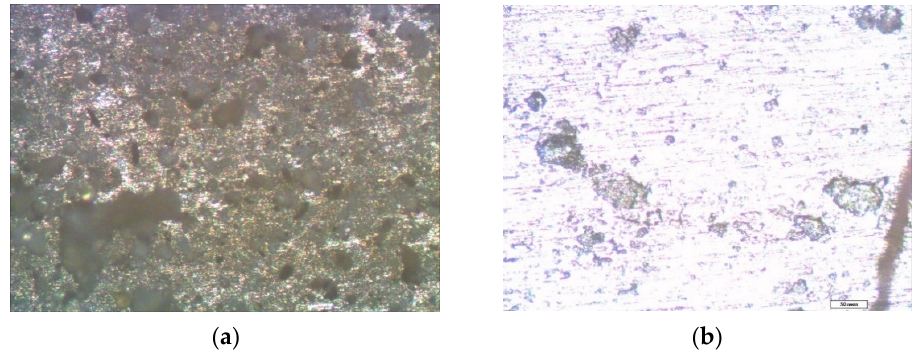
Figure 10. Micrographs of the surface area of a zinc sample pre-modified with a solution containing a mixture of [1% VS + 1 mM BTA], after conducting full-scale, one-year natural tests in an urban atmosphere: ( a ) immediately after testing but before the removal of the corrosion products; and ( b ) after the removal of the corrosion products. Optical magnification of 10×.